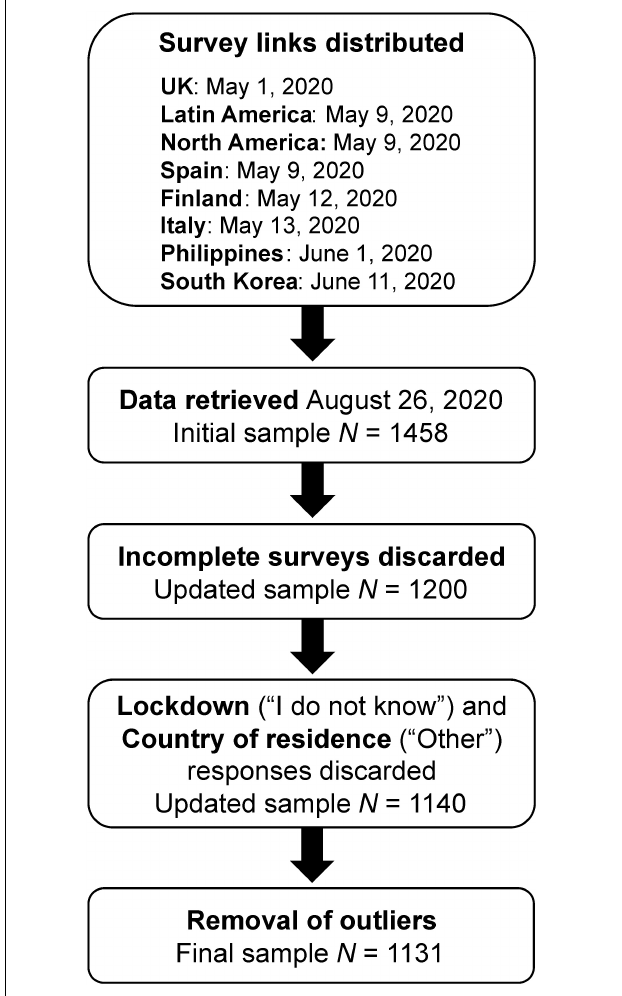
FIGURE 1 | Flow diagram illustrating the data collection process and data used in the